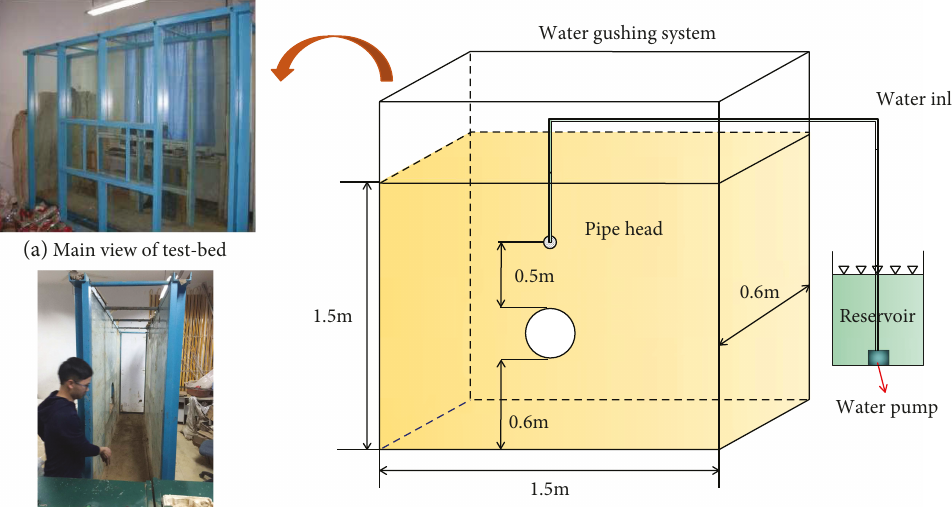
Figure 3: Sketch map of the model test apparatus.